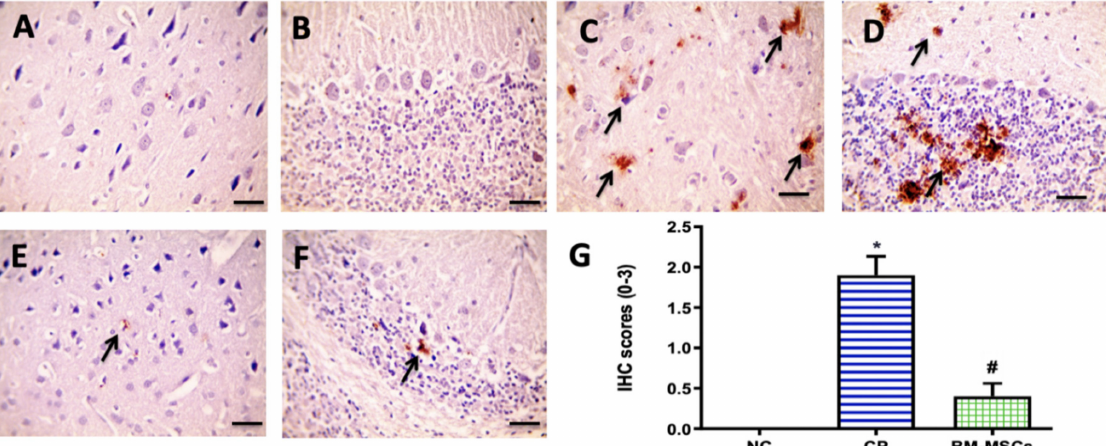
Figure 6. Microscopic pictures of immunostained cerebral ( A ) and cerebellar ( B ) sections against caspase-3 displaying negative staining in the NC group. Cerebral ( C ) and cerebellar ( D ) sections from CP group showing marked positive expression in neurons (black arrows). Meanwhile, cerebral ( E ) and cerebellar ( F ) sections from BM-MSCs group, showing very mild positive expression in neurons (black arrows). × 400, bar 50 µ m. Statistical analysis of the IHC scores of caspase-3 expression in immunostained brain sections ( G ). * p < 0.05 vs. NC group, # p < 0.05 vs. CP group. NC: normal control, CP: cisplatin, BM-MSCs: bone marrow-derived mesenchymal stem